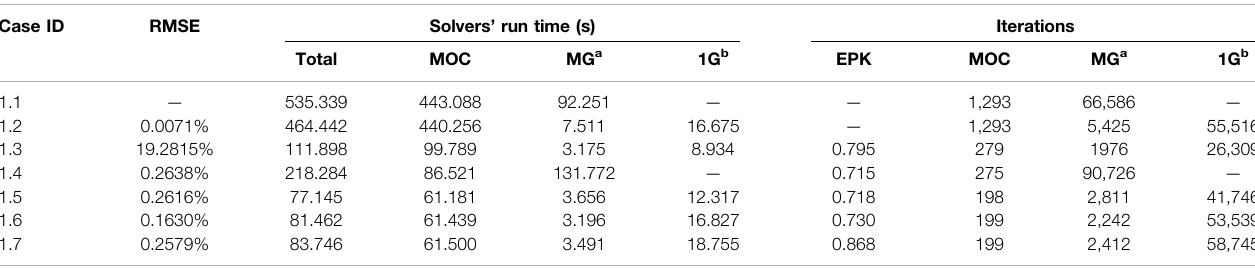
TABLE 2 | Results of accuracy and ef fi ciency for the cases in Problem 1.